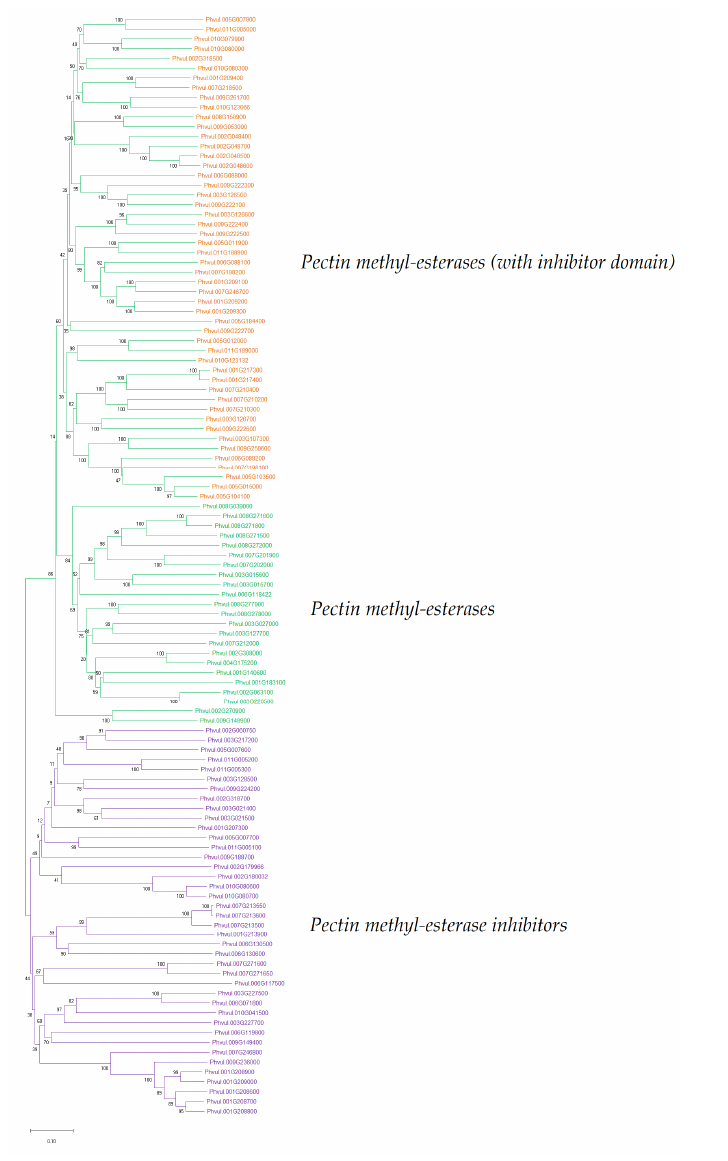
Figure 2. Phylogenetic tree showing the evolutionary relationship of a total of 113 genes encoding pectin methyl-esterases and pectin methyl-esterase inhibitors in P. vulgaris . The tree was inferred using the neighbor-joining method, and the evolutionary distances were computed using the p-distance method in MEGA software [34].